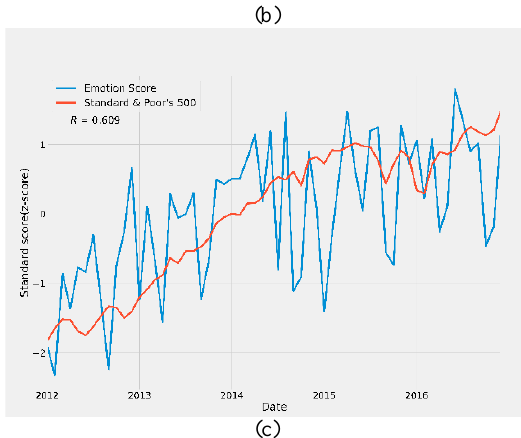
Figure 4 Line graph of correlation between emotion scores and (a) DJIA values; (b) NASDAQ values; (c) S&P values 3.6 Visualization of sensitive regions The sensitivity map of emotion score to the stock market was designed to illustrate where the sensitive regions are. From Figure 6, it can be observed that Broadway Theatre, Times Square, which are located in Midtown of Manhattan have a higher correlation coefficient (0.622 and 0.410). Penn Station also has a high correlation level of 0.511. Statistics demonstrated that results in these regions are significant. The region where the World Trade Centre and the Wall Street are located also have a positive correlation of the stock market with 0.234.